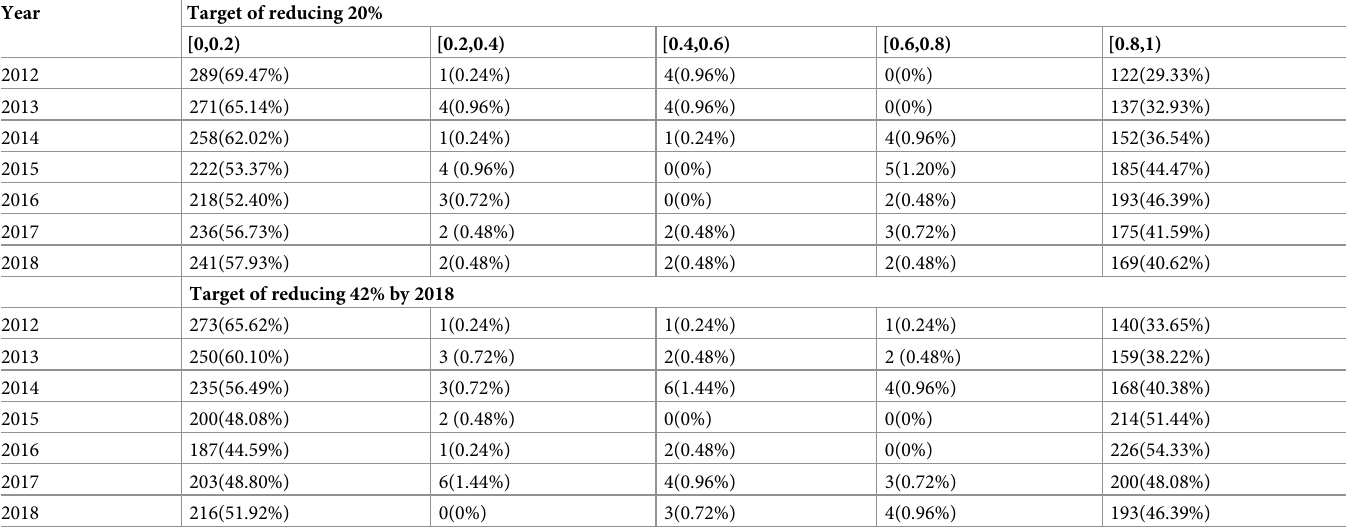
Table 5. The sectors that did not achieve reducing the